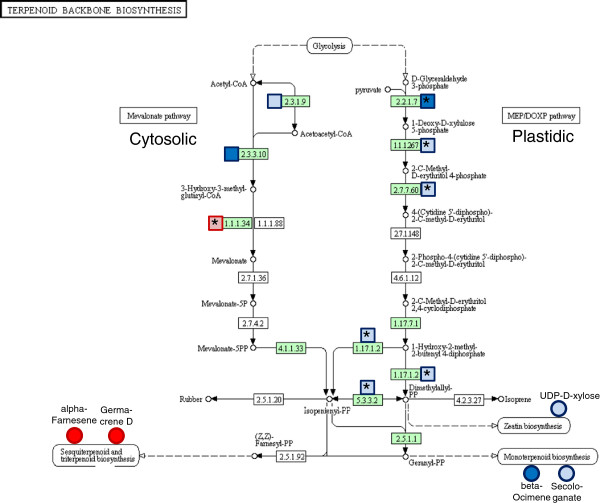
Combined mapping of transcriptomic and metabolomic data onto the KEGG reference pathway “terpenoid backbone biosynthesis”. Log2 fold changes of RPKM ratios according to Additional file 5 and of mass intensities according to Additional file 4 were mapped on the KEGG reference pathway. Enzymes highlighted in green are enzymes present in the Q. robur reference transcript set that was used for as a reference for quantification of the transcript data. Log2 fold changes of alpha-Farnesene, Germacrene D, and beta-Ocimene were taken from Ghirardo et al.[29]. Boxes/circles in light red, TFED > SFED (0.2 ≤ log2 fold change of RPKM/mass intensity ratio < 1.0); boxes/circles in dark red, TFED > > SFED (log2 fold change of RPKM/mass intensity ratio ≥ 1.0); boxes/circles in light blue, TFED < SFED (-1 < log2 fold change of RPKM/mass intensity ratio ≤ -0.2); boxes/circles in dark blue, TFED < < SFED (log2 fold change of RPKM/mass intensity ratio ≤ -1.0); big asterisk in the box, specific mapping of the transcript to the pathway “terpenoid backbone biosynthesis”; no asterisk in the box, unspecific mapping of the transcript to several pathways.